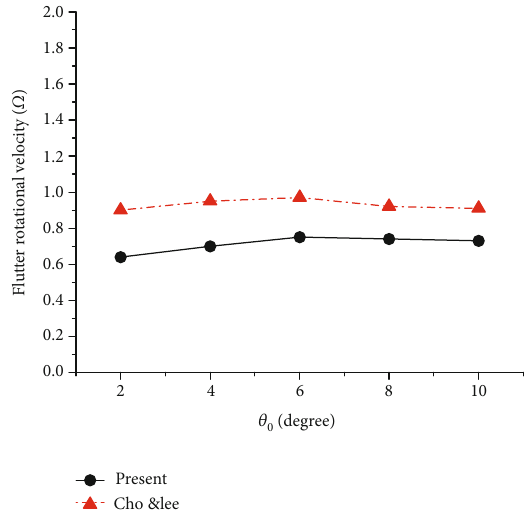
Figure 9: Flutter rotational velocities of the blade ( AR = 12 : 5